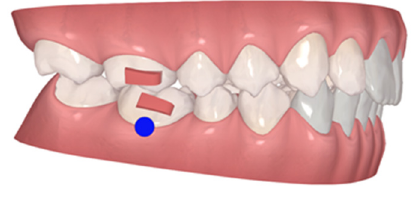
Figure 12. Fourth AA stage. Blue dot—moderate movement.